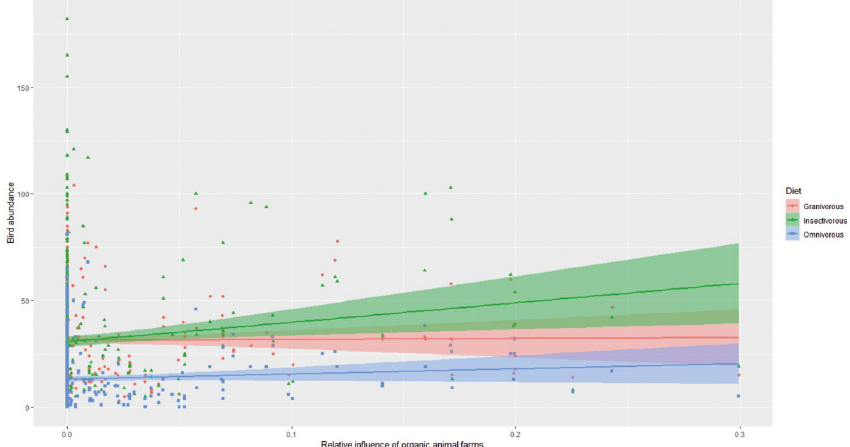
Fig 3. Effects of organic animal farms on bird abundance by diet class. The differential effect of relative influence of organic animal farms (averaged within a 300m radius from each transect line, see Fig 1b) on the summed abundance of granivorous, insectivorous and omnivorous (including raptors) birds. Values are based on the original untransformed data. The results of the interaction between relative influence of organic animal farms and birds diet are presented in Table C in S1